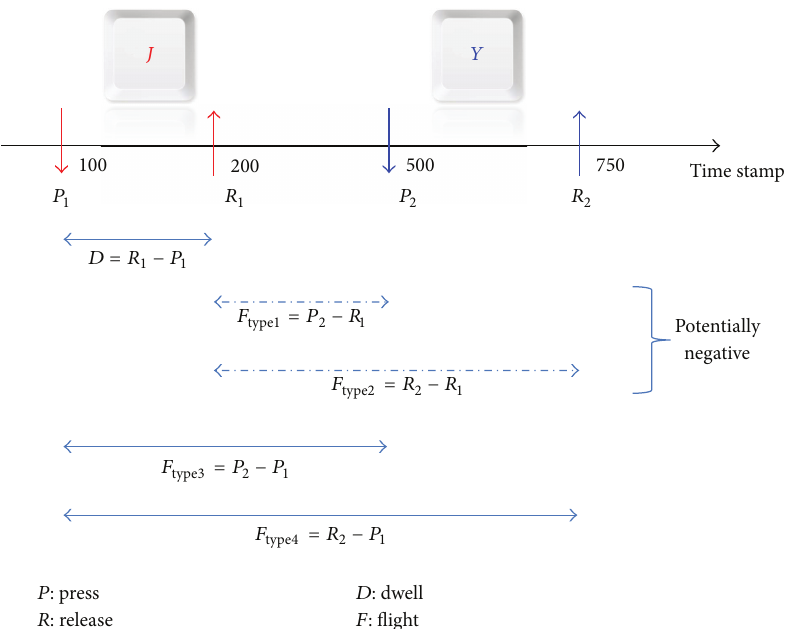
Figure 7: Figure depicts the different keystroke events of two characters “ 𝐽 ” and “ 𝑌 ” along side with the formation of dwell time and flight